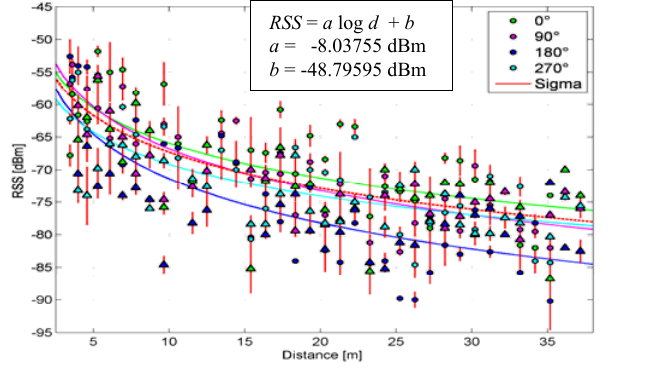
Figure 4. Logarithmic relationship of the RSS to the range d along a straight line between two APs for one smartphone